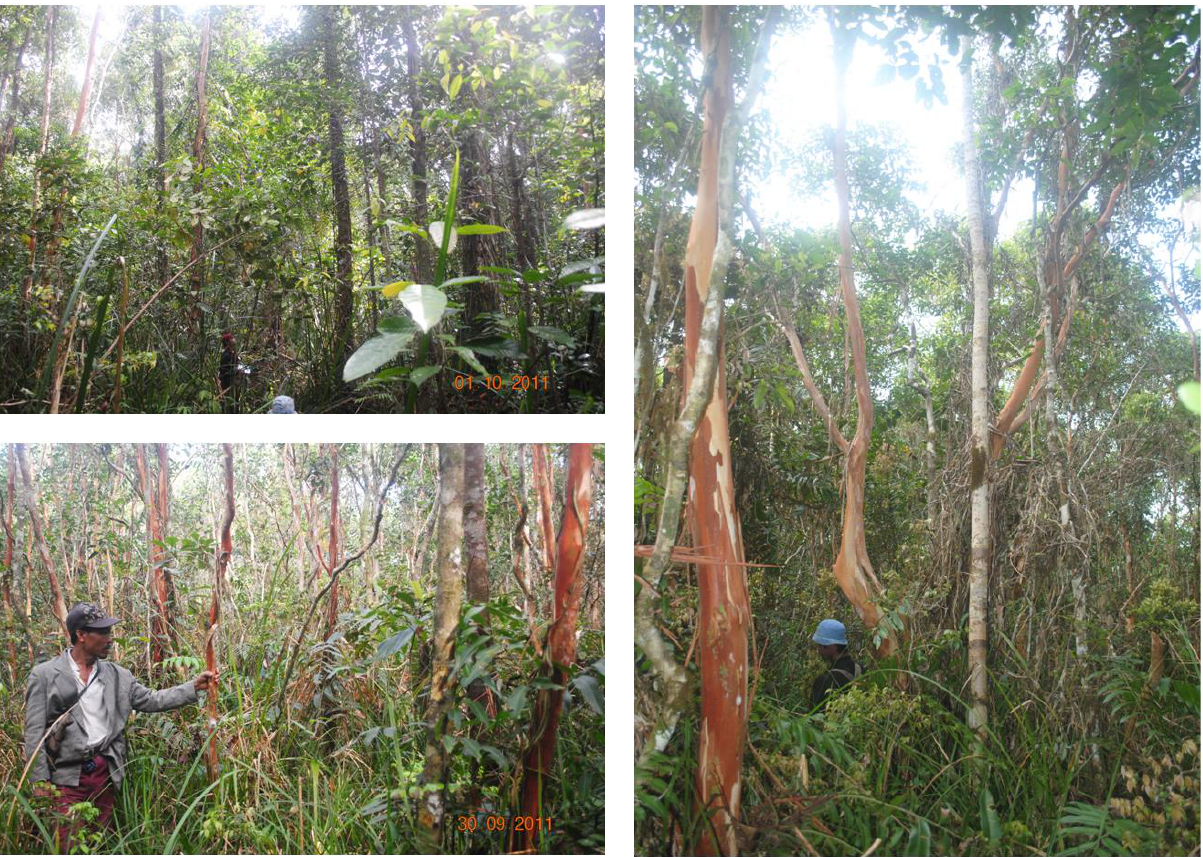
Figure 3. Examples of three of the forest types distinguished at the Caimpugan peatland, namely: tall pole forest (top left), tall intermediate forest (right) and low intermediate forest (bottom